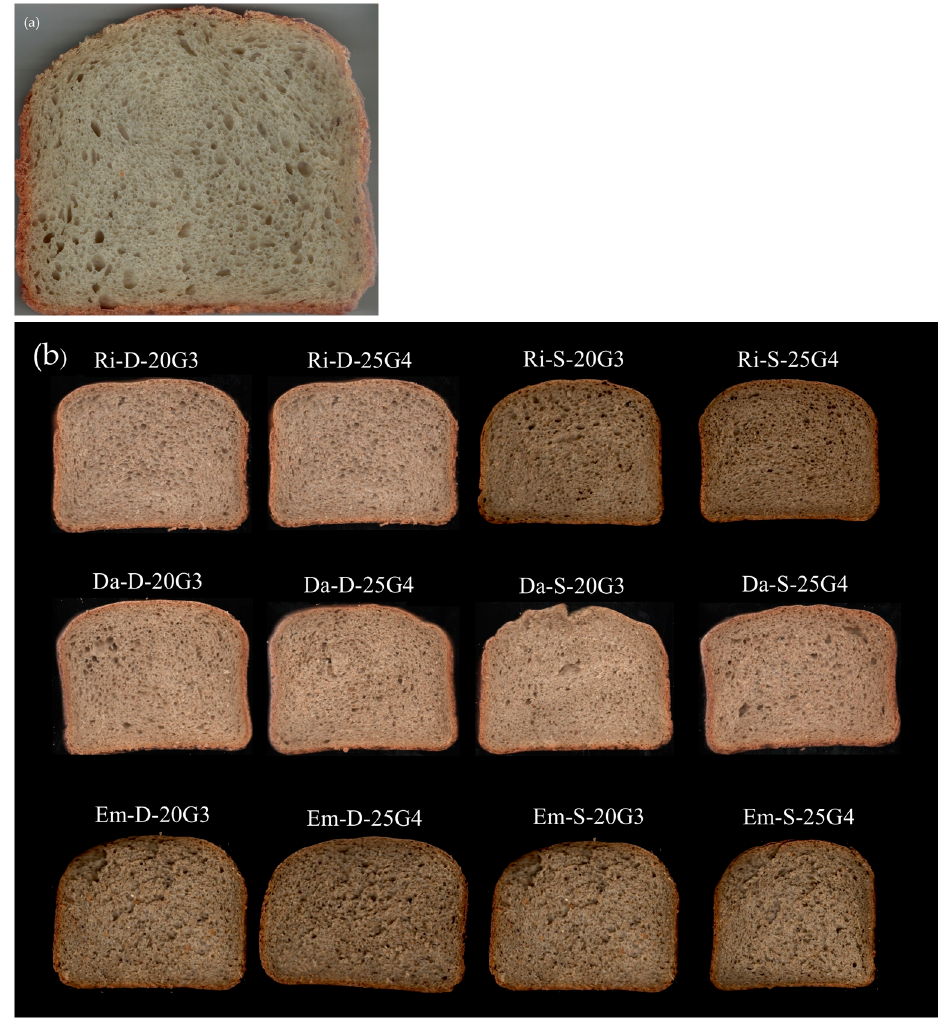
Figure 1. Slices of ( a ) control bread and ( b ) the 12 functional breads produced. Table 2. Ingredients (g) used in bread formulations.